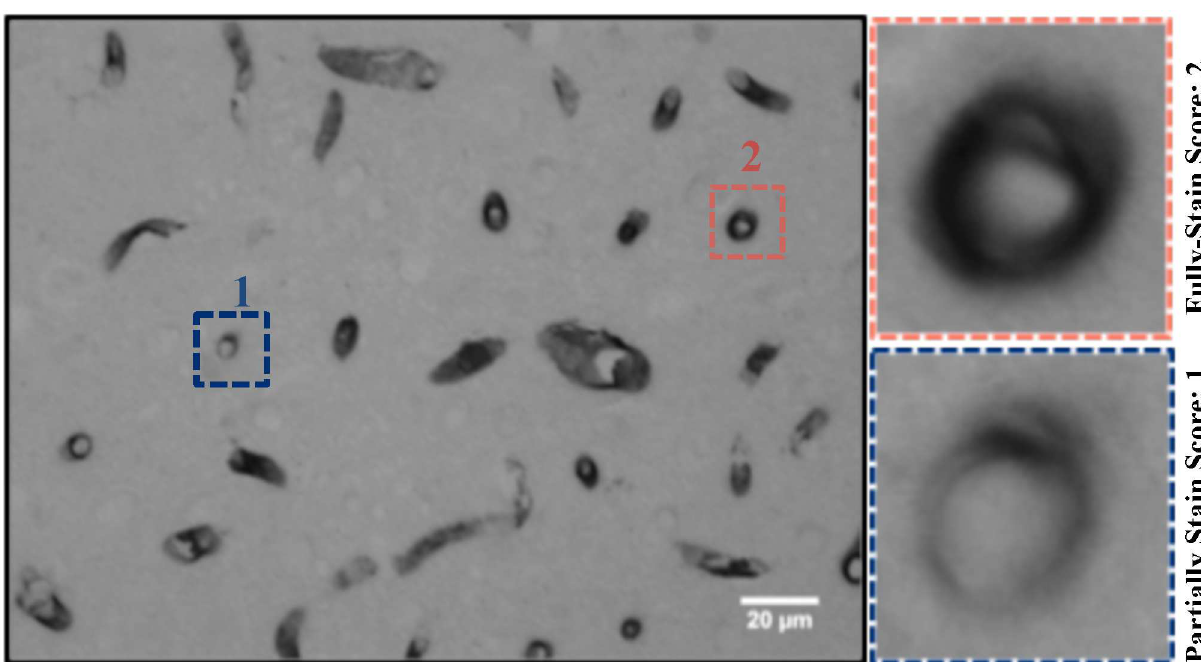
Fig 3. Method of scoring Pgp intensity after immunohistochemical staining. The microphotograph shows a section from the anterior right caudate putamenat a depth of 3 mm relative to the dural surface, the depth of the focal plane.The monoclonal antibodyC219 was used for Pgp staining. Prominent immunoreactivity is evidentin endothelialcells of capillaries.The intensity of the P-gp reaction was scored for each vessel in the section on a scale from 0–2, with 0 = not stained, 1 = partially-stained, 2 = fully-stained. Scale bar: 20 μ m.